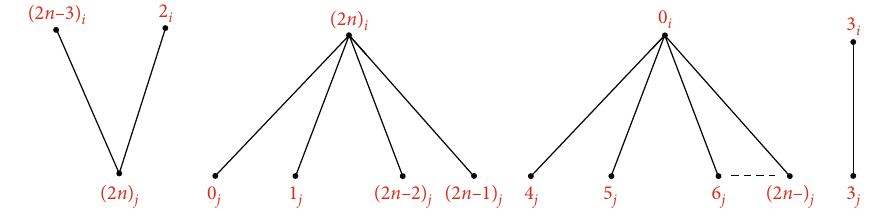
i , j : ∪ K ∪ K ∪ K 1,1 1,2 1,4 1,2 n ‐ 6 Þ